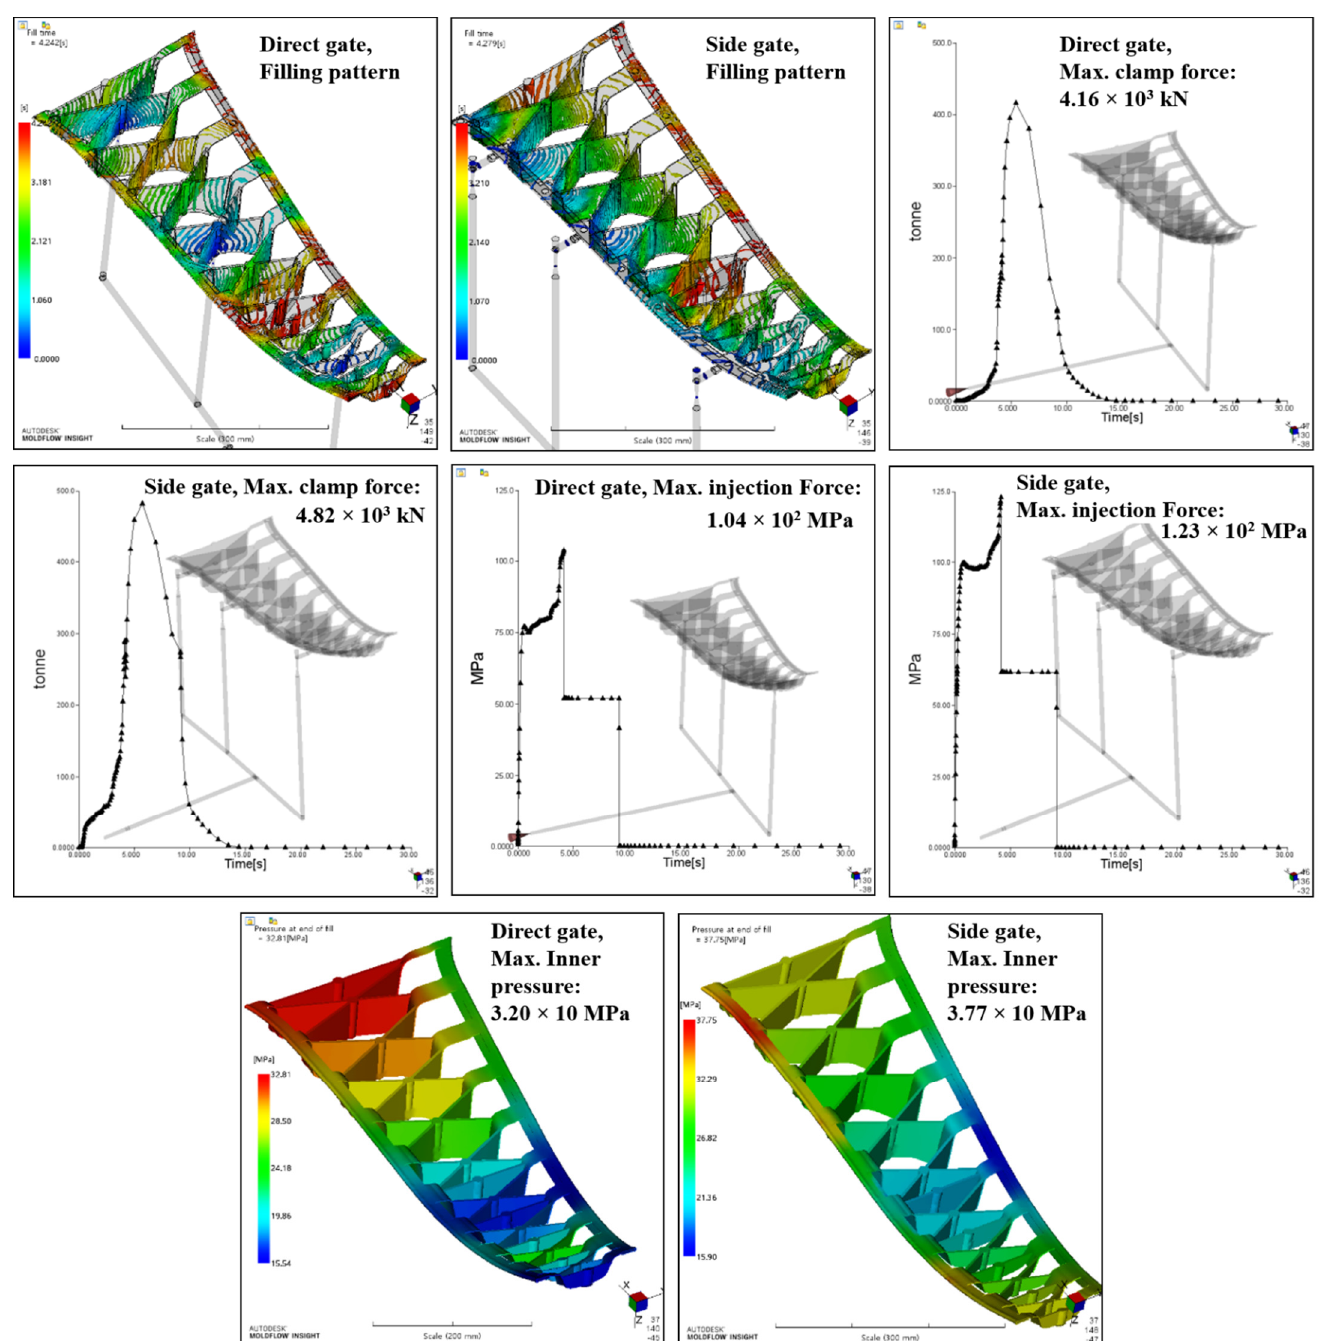
Figure 23. Injection analysis results for direct gate and side gate conditions: Filling time, maximum clamp force, maximum injection force and maximum inner pressure.